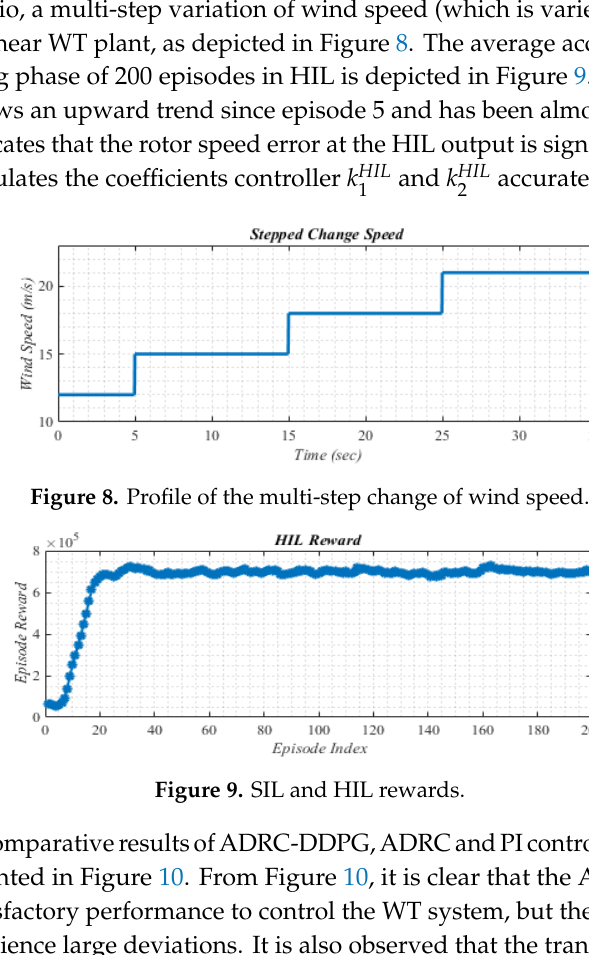
Figure 9. SIL and HIL rewards.